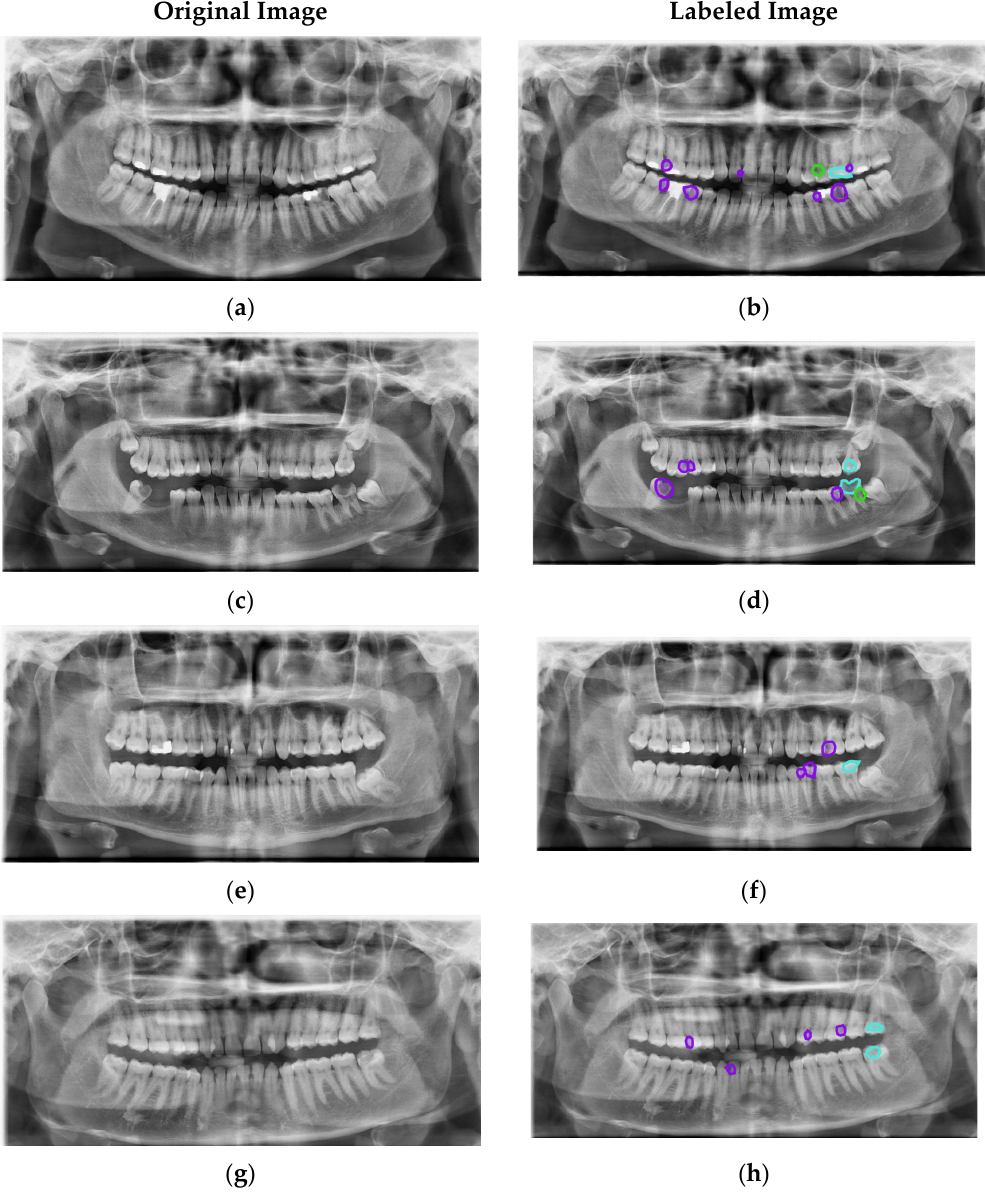
Figure 1. Example images ( a , c , e , g ) and labels ( b , d , f , h ). Type I (Occlusal caries). Type II (Proximal caries). Type III (Cervical caries).